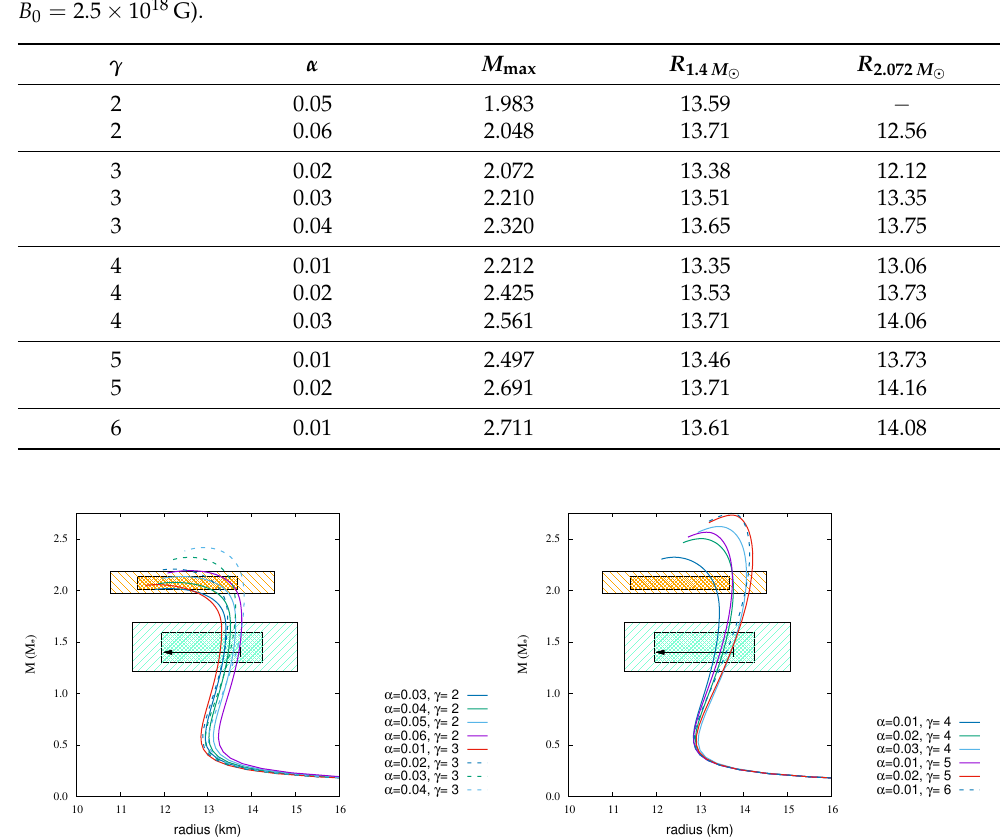
) for TM2 ωρ -a EoS with magnetic fields ( B s = 10 12 G, (cid:12)